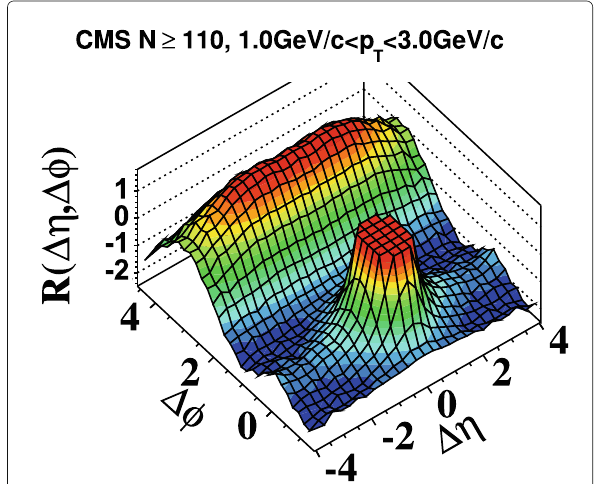
Fig. 13 Two-particle correlation as functions of relative azimuthal angle (cid:2)φ and pseudorapidity (cid:2)η for high multiplicity events in p+p √ s NN = 7 TeV from the CMS experiment collisions at